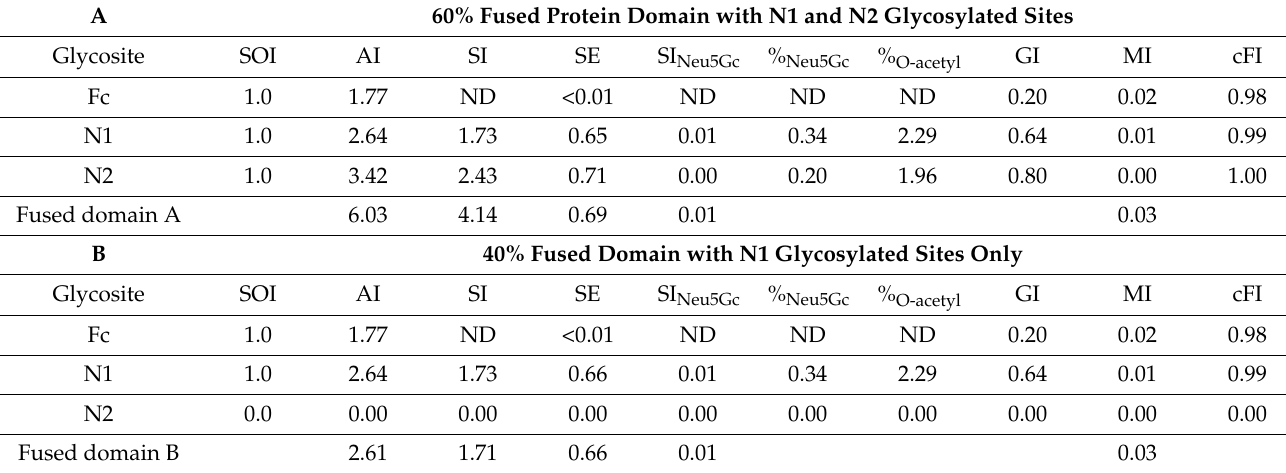
Table 5. Scenario of the heavy chain fused protein domain populations (A, SOI N2 = 1) and (B, SOI N2 = 0) present in the RHS molecule.